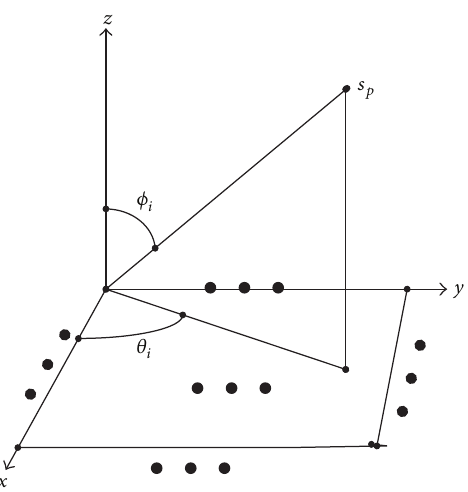
Figure 1: Uniform rectangular array